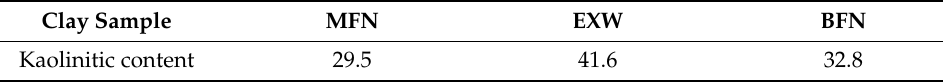
Figure 4. TGA results of the raw clay samples. Table 3. Determined kaolinitic content of the raw clay samples.